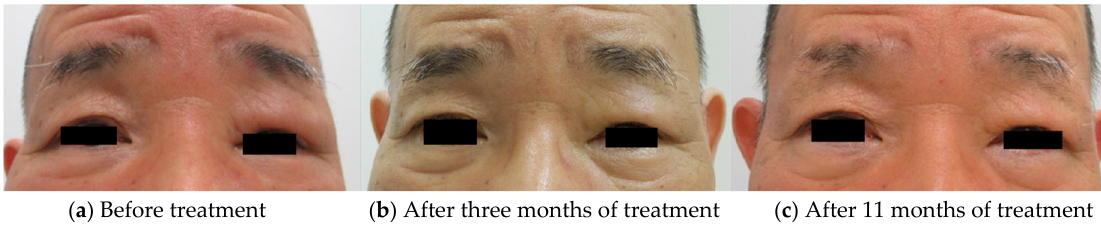
Figure 2. ( a , b ) The patient’s left upper eyelid is swollen, and a single, erythematous, indurated lesion is seen. ( c ) Improve- ment in swelling and erythema after treatment.